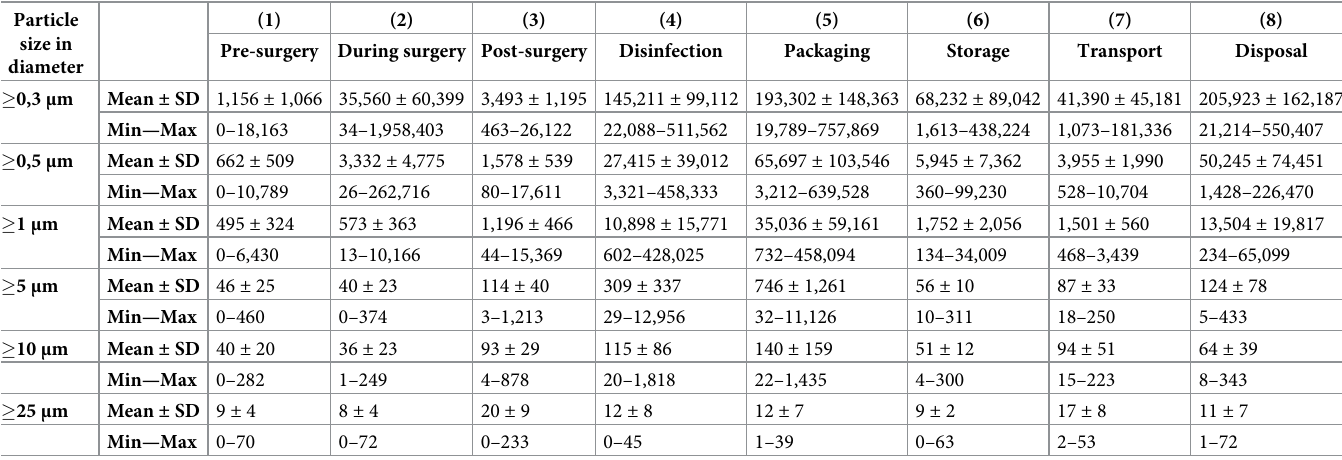
The mean values, standard deviations (SD), minimum (Min), and maximum (Max) values of airborne particle load with different diameters of all surgeries (average) were analyzed with a particle counter during use and reprocessing (1–8). Particle load is shown as numbers/m 3 [no./m 3